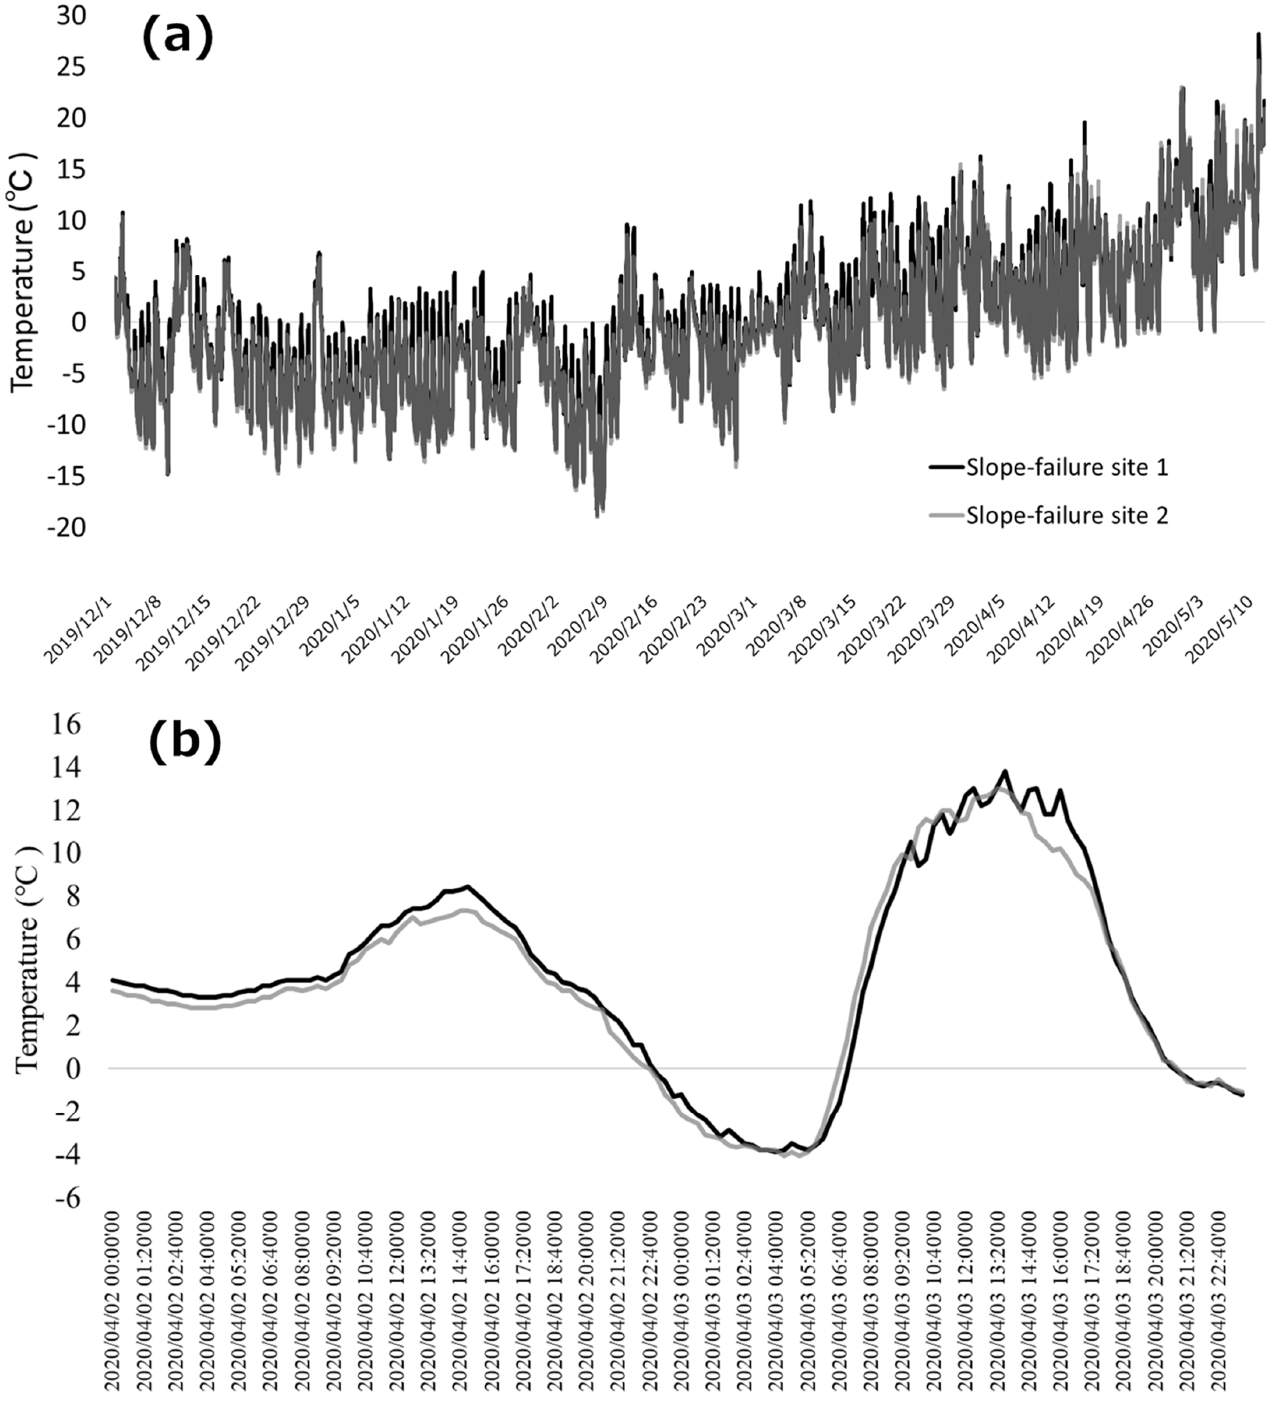
Figure 2. ( a ) Temperature changes at two sites from December 1, 2019 to May 12, 2020. ( b ) Temperature changes at two sites from April 2 to 3, 2020.